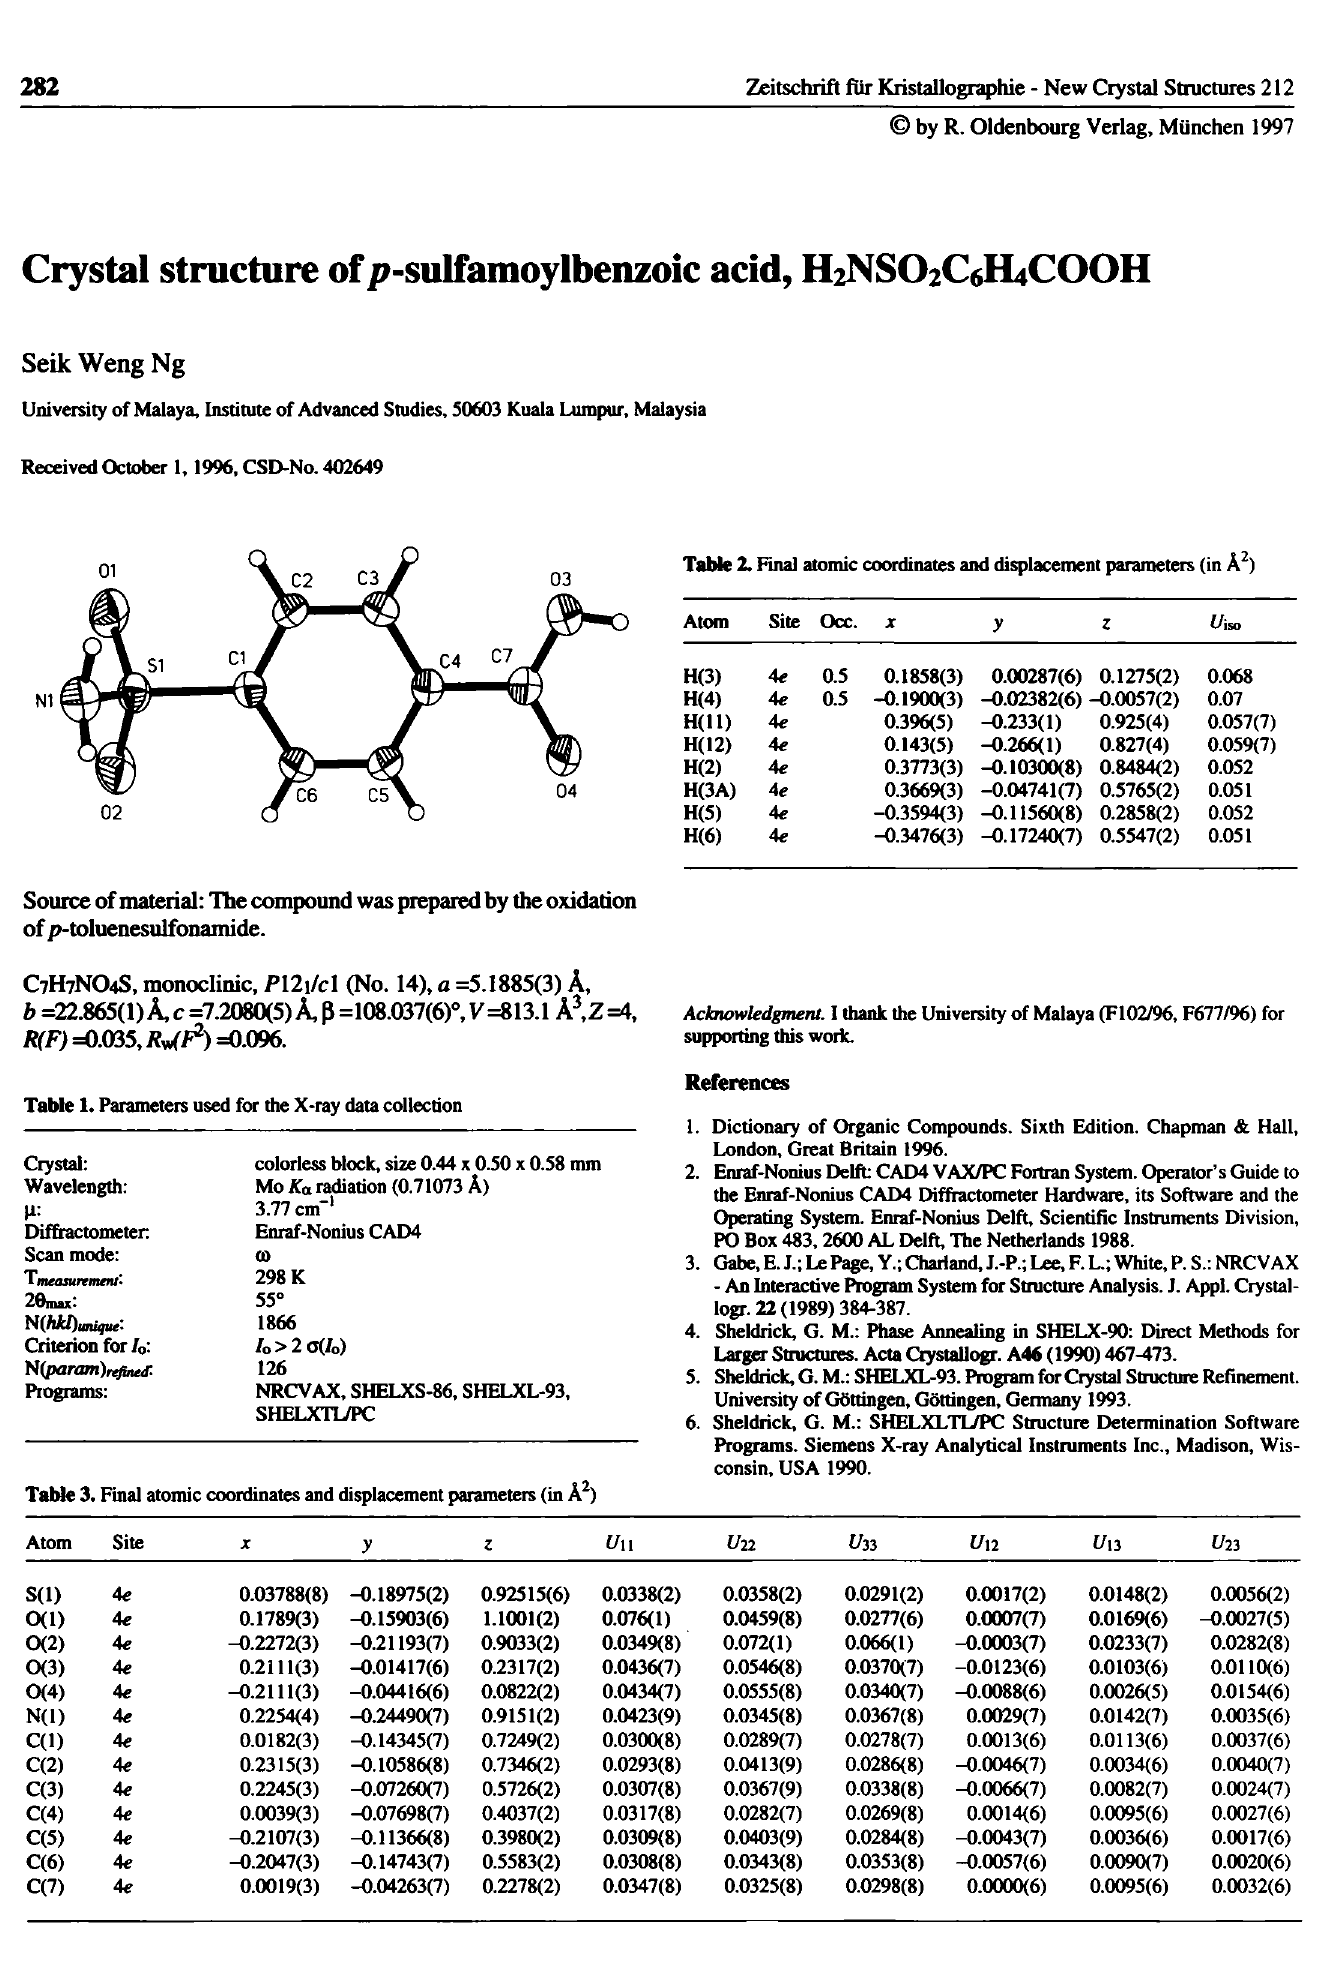
Table 3. Final atomic coordinates and displacement parameters (in Â 2